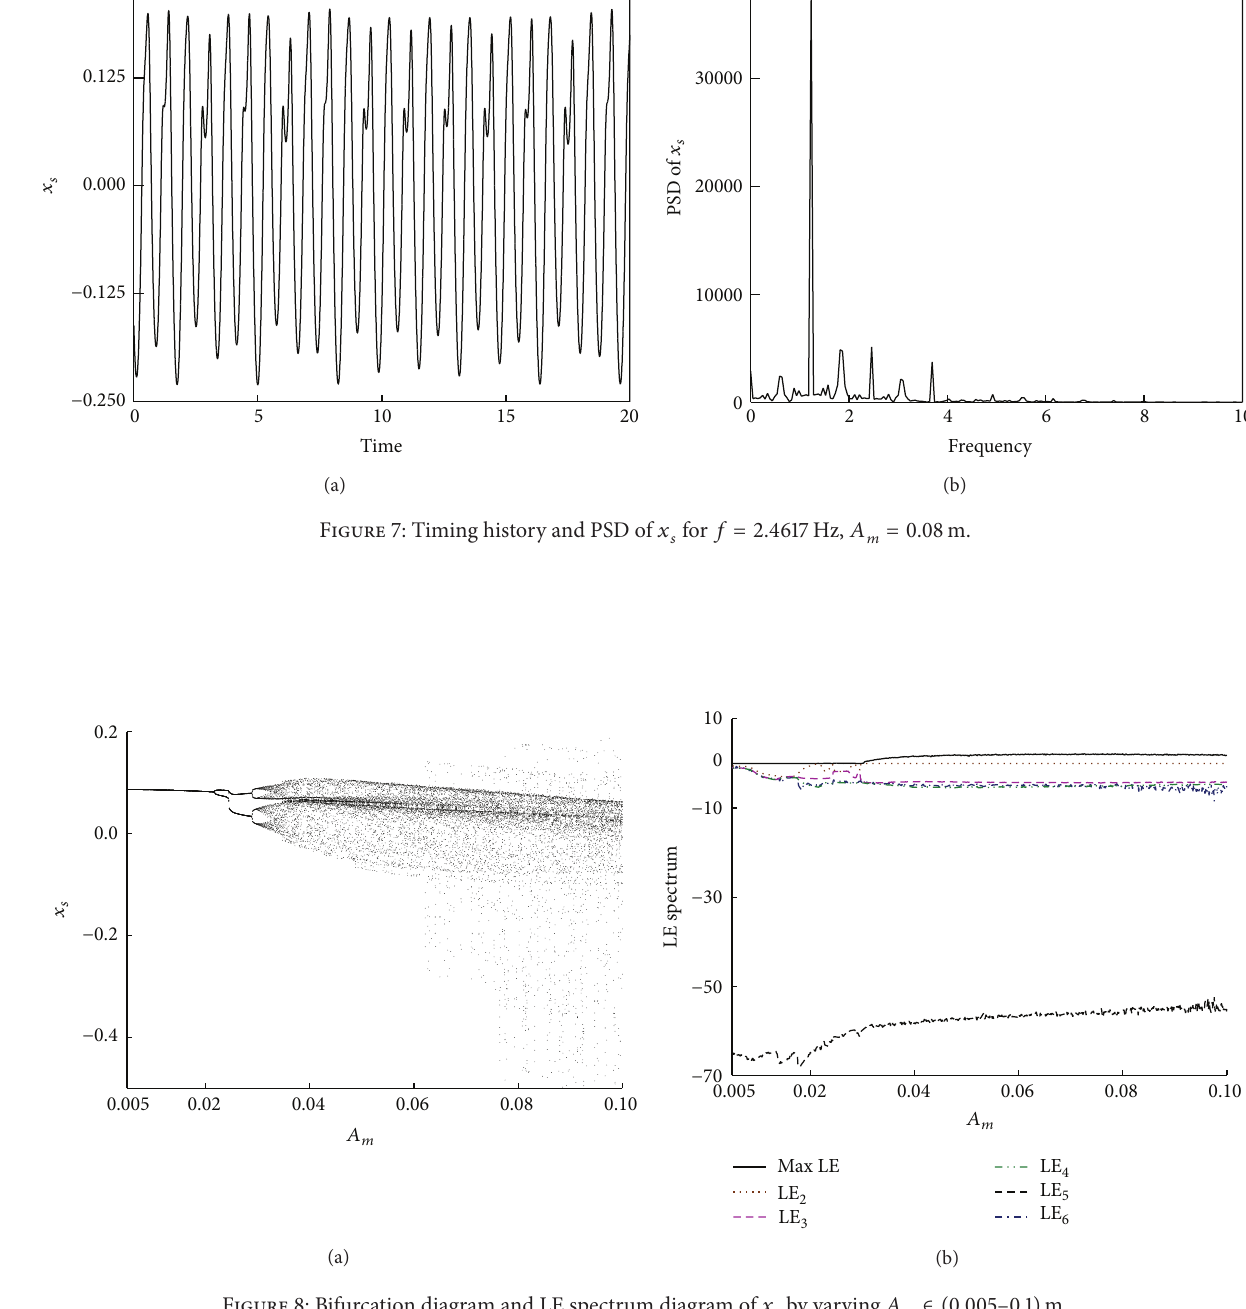
Figure 8: Bifurcation diagram and LE spectrum diagram of 𝑥 𝑠 by varying 𝐴 𝑚 ∈ ( 0.005–0.1)